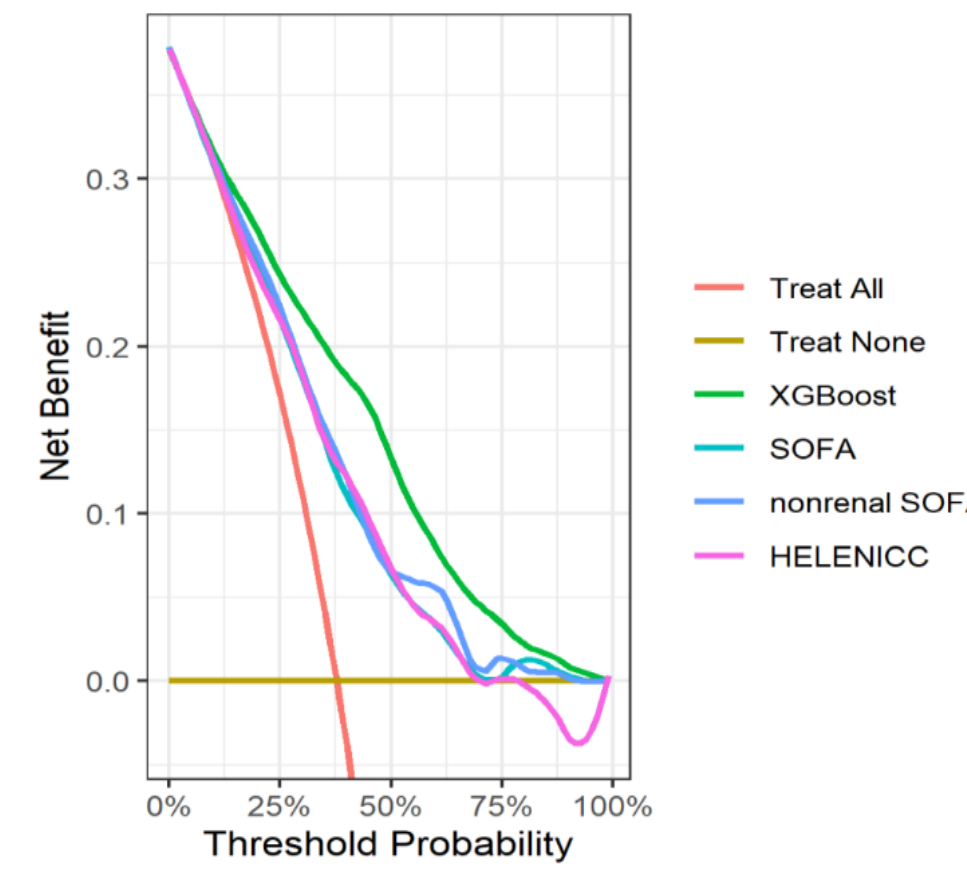
Figure 5. Decision curve analysis of random forest, SOFA, nonrenal SOFA, and HELENICC for 30-day mortality prediction. Table 4. Model performance measures in the pooled dataset.